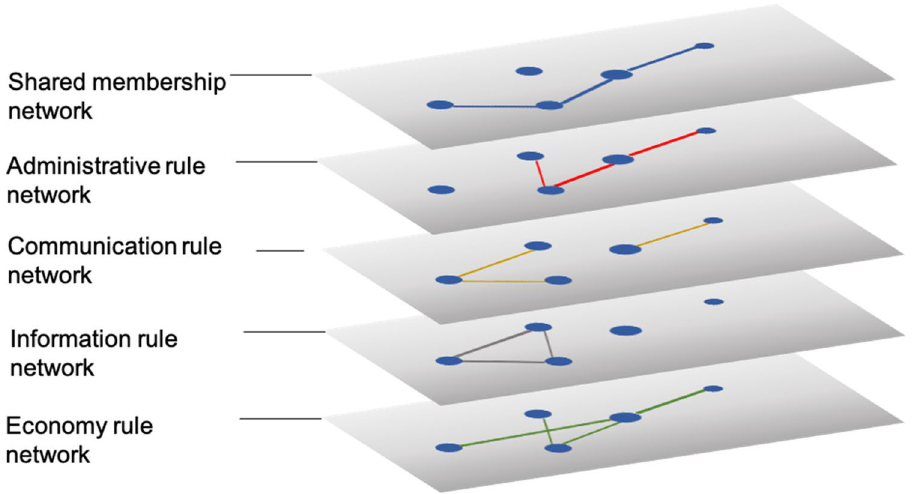
Figure 5. A multiplex network representation of many servers’ patterns of shared membership and common institutional structure. We layered the community network and four rule networks on top of each other to construct a multiplex network. The nodes in each layer, which signify the servers, are the same, whereas the relations in different network layers have different meanings. We consider servers to be culturally similar